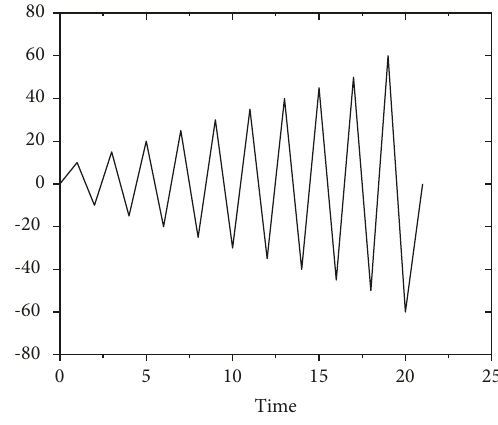
Figure 6: Loading regime table.